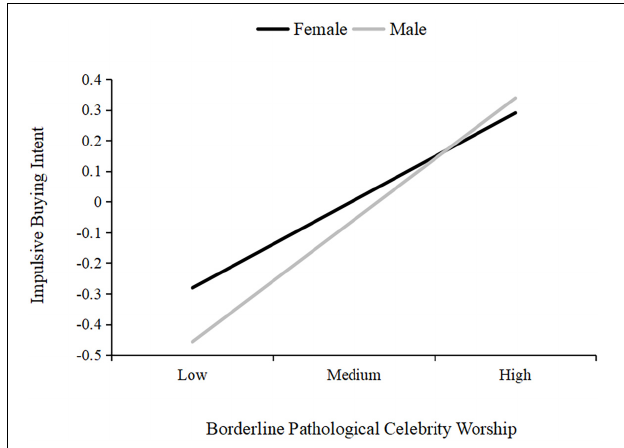
FIGURE 4 | The moderating effect of gender on the relation between borderline pathological celebrity worship and impulsive buying intent. Borderline pathological celebrity worship was graphed for two levels: 1 standard deviation above the mean was high level and 1 standard deviation below the mean was low level. Variables in the models are